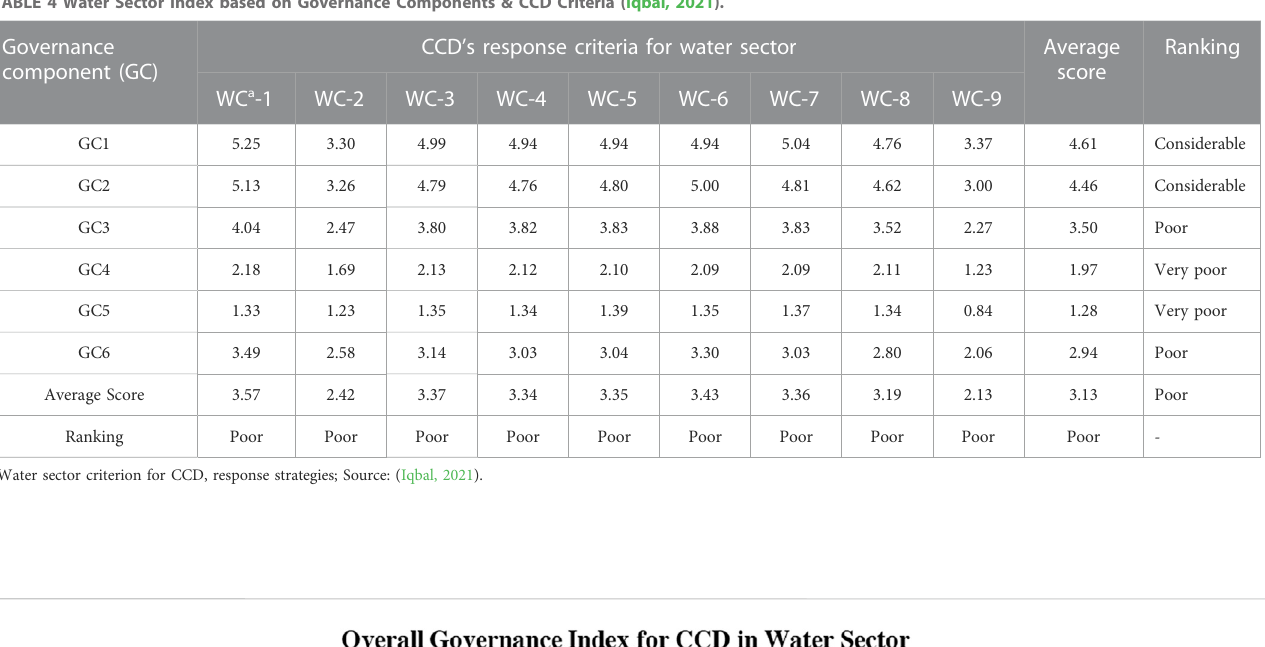
TABLE 4 Water Sector Index based on Governance Components & CCD Criteria (Iqbal, 2021).